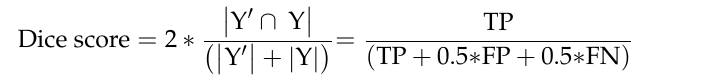
Figure 5. The 3D MRI from BRATS-2020 brain image dataset.